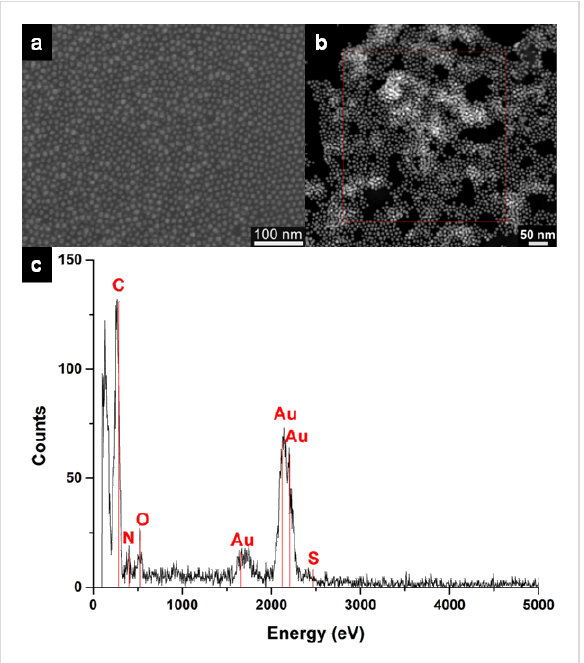
Figure 1: Characterization of Au-NP–S-BPP arrays and networks by electron microscopy. a) SEM image of a 2D single-layer microcontact printed Au-NP–S-BPP array on a flat Si–SiO 2 substrate; b) STEM- reference image of a Au-NP–S-BPP network area on a TEM grid sub- strate; c) local EDX analysis revealing the elemental